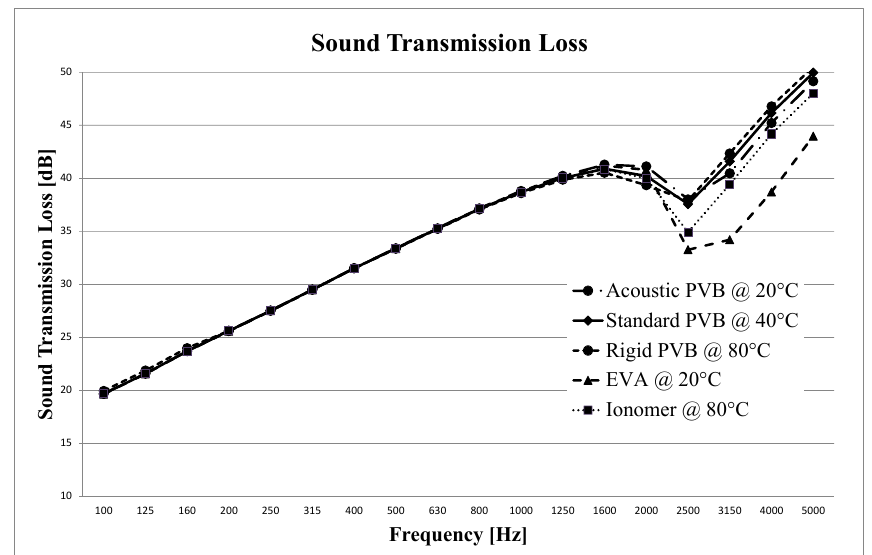
Fig. 16 Sound Transmission Loss comparison of different PVBs at different temperatures Regarding EVA (Fig. 17), this interlayer is typically not being used for its acoustic performances. Even if it shows better transmission loss between 1000 and 2000 Hz, there are important dips in the coincidence frequencies at all measured temperatures.